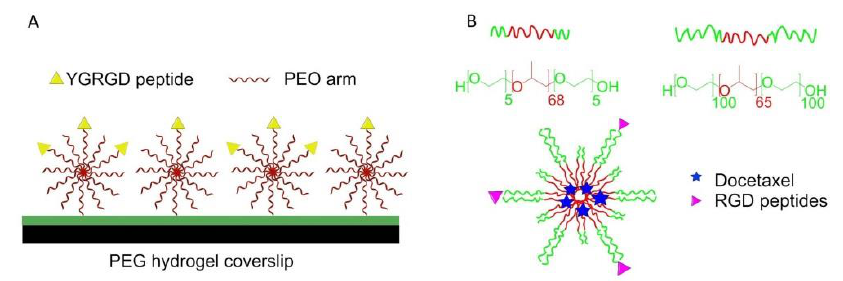
Figure 9. Blending strategy for surface functionalization. ( A ) Star PEO was blended on the surface. The surface density of star PEO and special distribution of RGD peptides can be controlled. ( B ) Preparation of cRGD-conjugated tumor-targeting drug delivery platform by blending of L121 and F127 and encapsulating docetaxel.